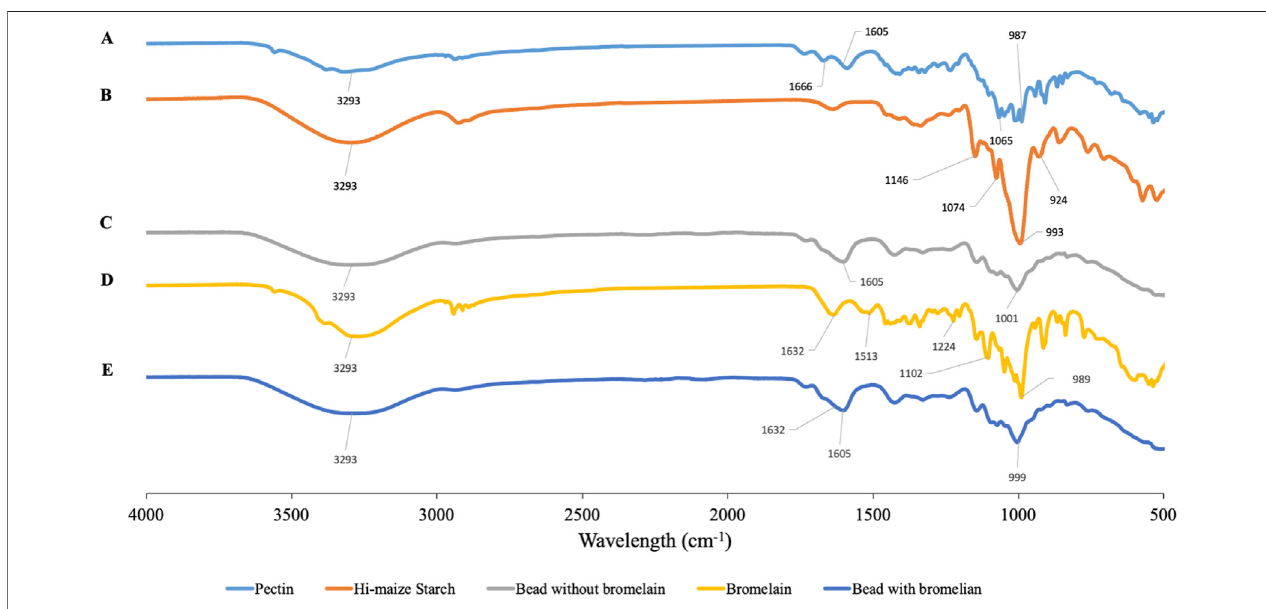
FIGURE 6 | FTIR spectra of pectin (A) , hi-maize starch (B) , hydrogel bead without bromelain (C) , bromelain (D) , and bromelain-loaded hydrogel bead (E) .